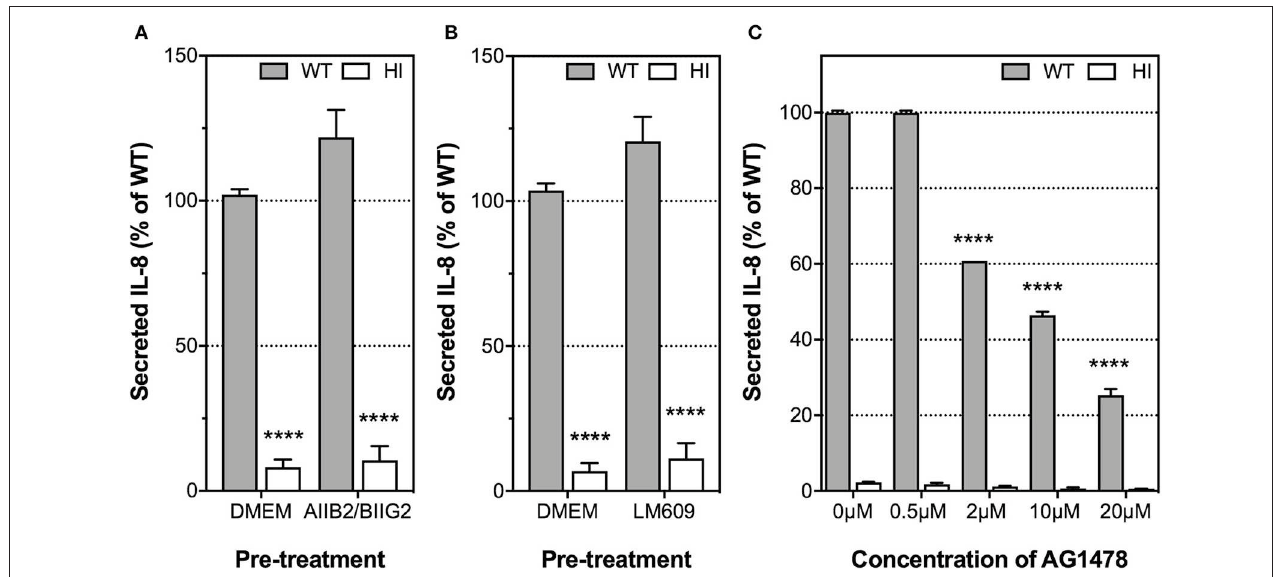
FIGURE 5 | The roles of integrin α 5 β 1 , integrin α v β 3 , and EGFR in IL-8 induction by H. pylori upon infection of HUVECs. Prior to incubation with H. pylori P12 (MOI = 1) or HI broth, HUVECs were pre-treated with the function-blocking antibodies (A) AIIB2 and BIIG2 (2 µ g/ml each), (B) LM609 (2 µ g/ml), or (C) EGFR small molecule inhibitor AG1478 at various concentrations indicated. Spent culture media was harvested at 24 hpi and assayed by ELISA for secreted IL-8. IL-8 levels are expressed as the mean percentage of that determined for P12 WT-infected HUVECs. (A,B) Error bars denote SEM, N = 3; statistical analysis using two-way ANOVA (Tukey’s multiple comparisons post-test); comparisons between infected and uninfected shown (**** p < 0.0001); antibody-treated and untreated samples were not significantly different. (C) Error bars denote SEM, N = 2. Statistical analysis of AG1478 dose-response by two-way ANOVA (Tukey’s multiple comparisons post-test); significant differences compared to 0 µ M are shown; **** p <